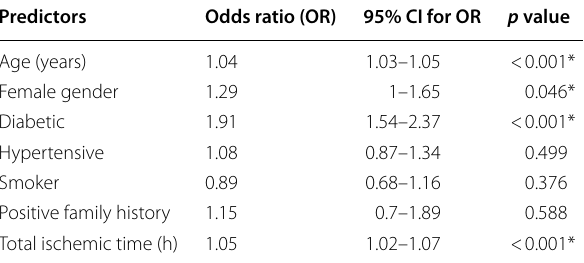
Table 3 Multivariable logistic regression analysis for in-hospital